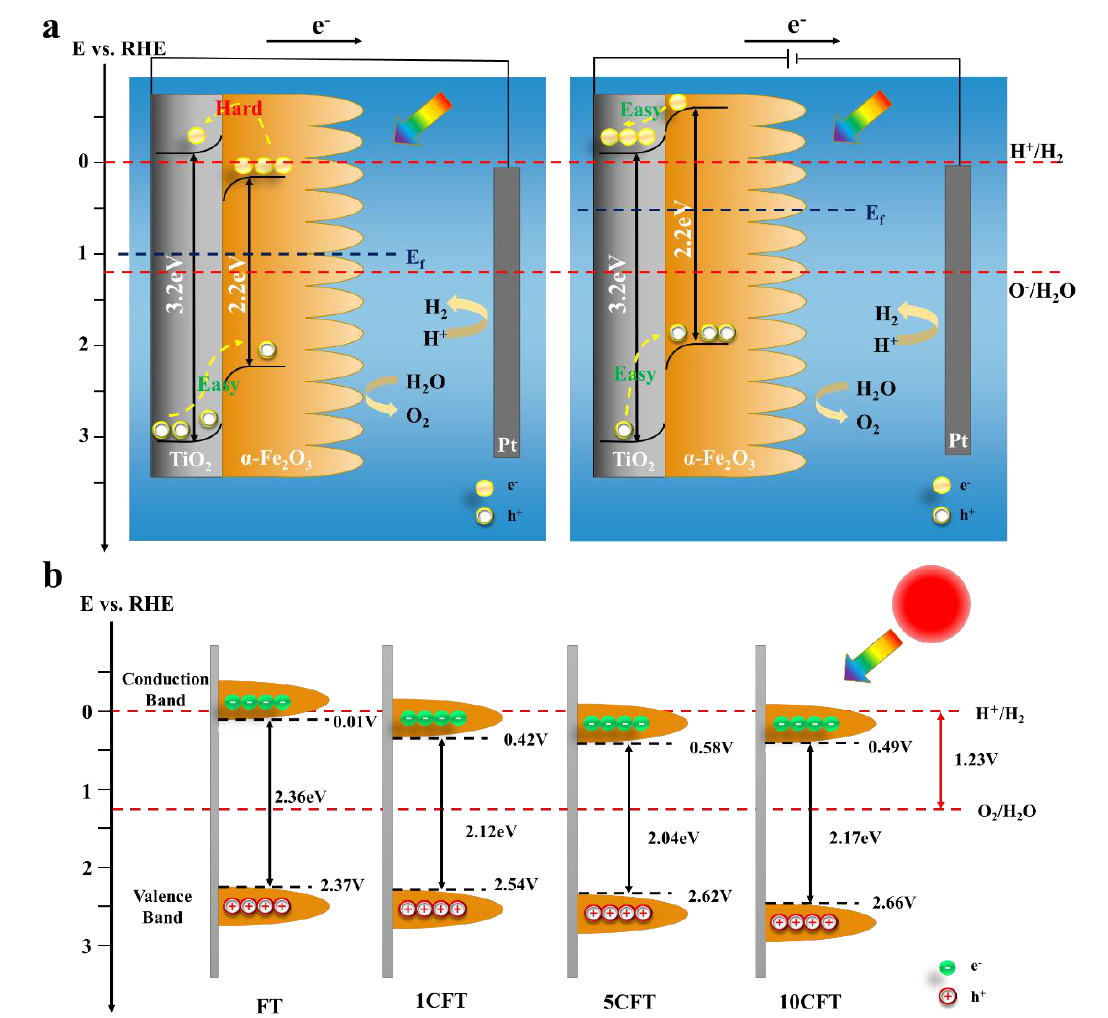
Figure 5. ( a ) The charge transfer mechanism of the PEC water splitting and ( b ) the schematic diagram of the band gap of Fe 2 O 3 (FT) and Ce-doped Fe 2 O 3 (1CFT, 5CFT, 10CFT).